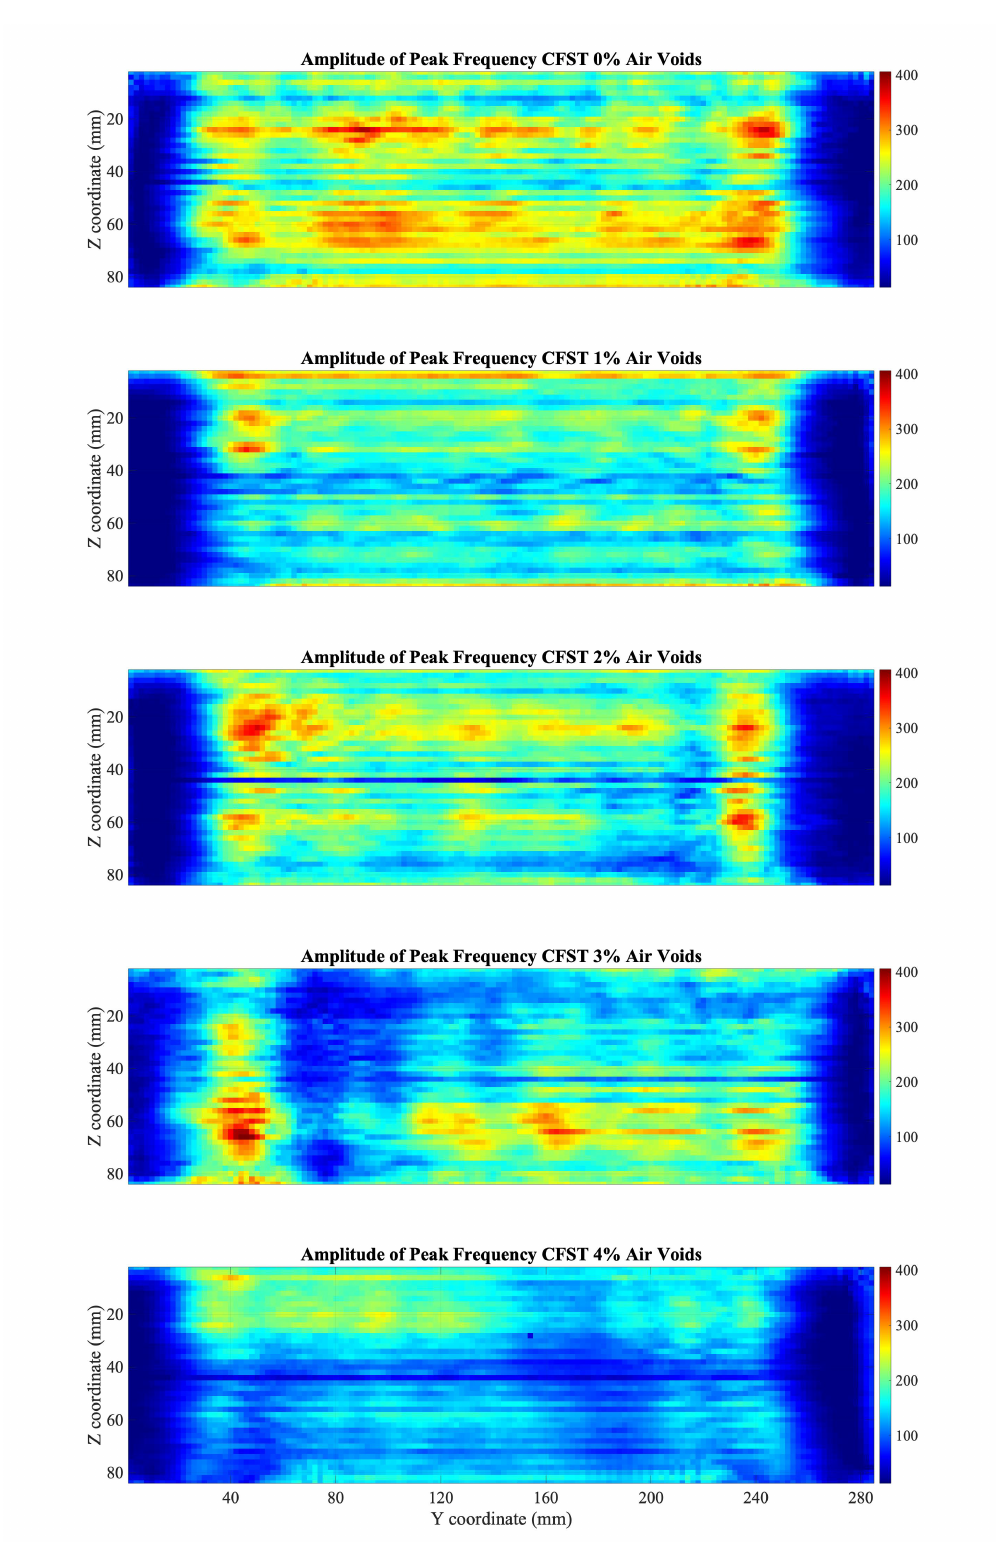
Figure 6. C-Scan of fundamental harmonic amplitudes using FFT for the five CFST